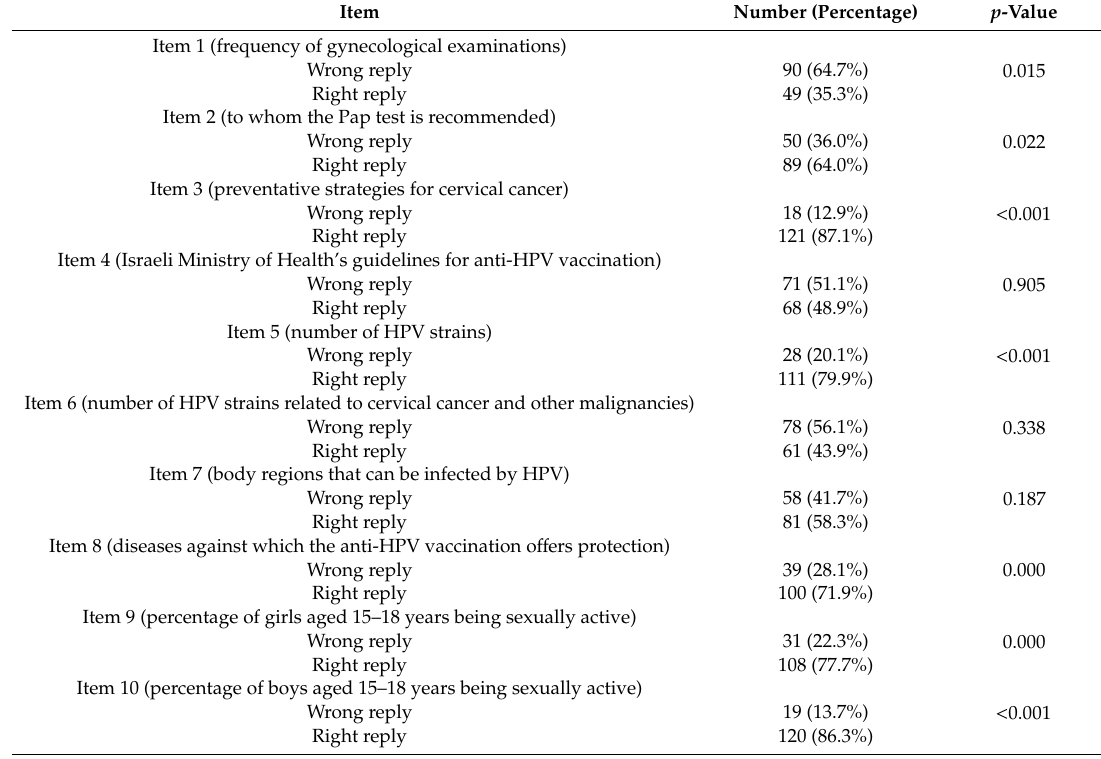
Table 4. Frequency of wrong and right replies for the second part (“level of HPV-related knowledge”) of the